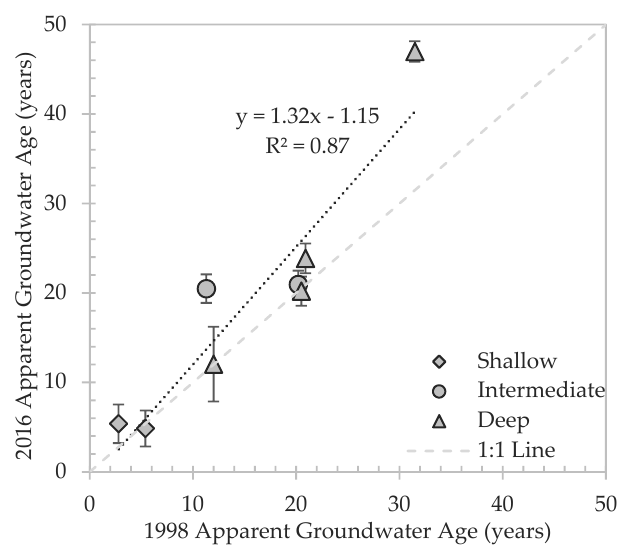
Figure 2. Apparent groundwater age determined in 2016 compared to apparent groundwater ages determined in 1998. Error bars are ±1 σ from 2016 analysis using the International Atomic Energy Agency (IAEA) model.